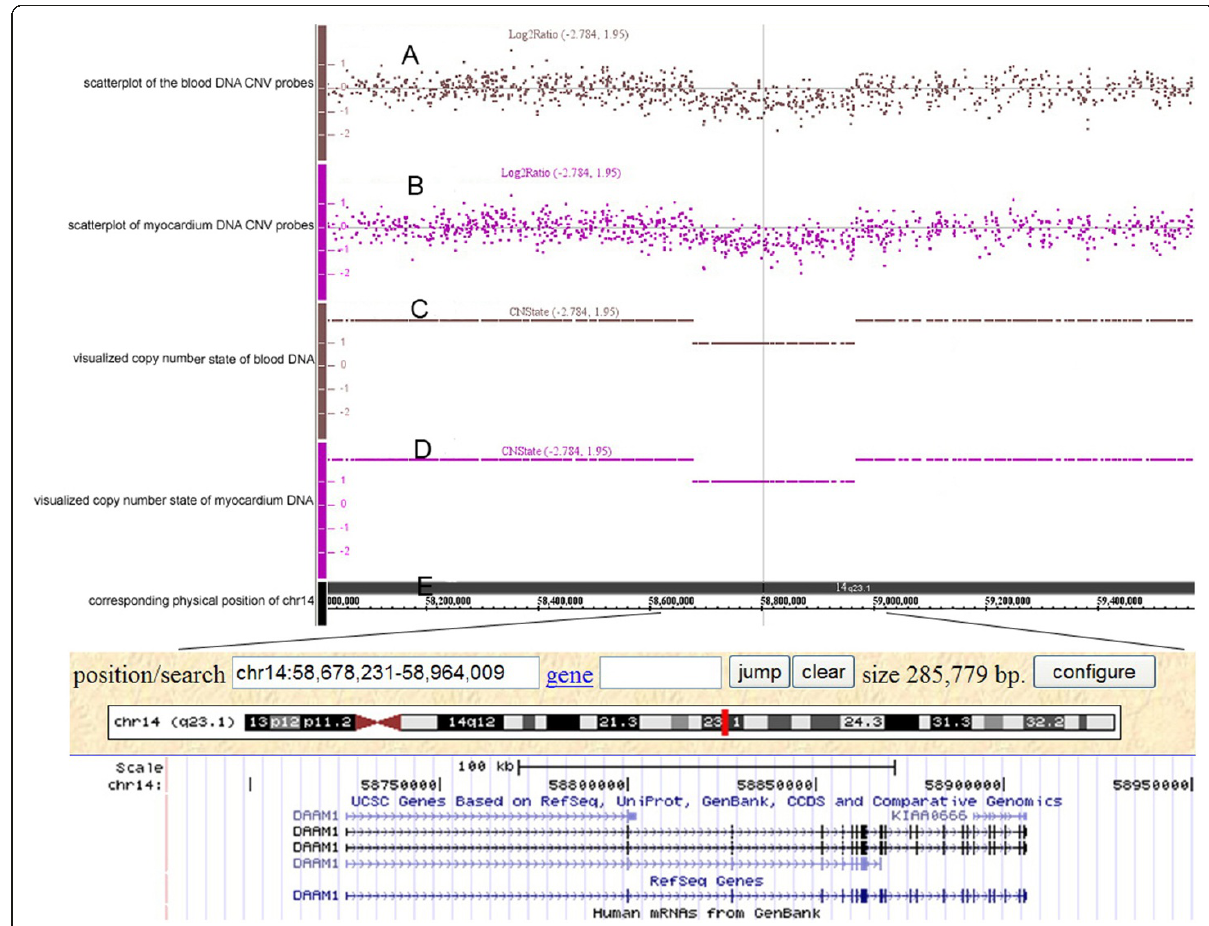
Figure 1 The copy number deletion region on 14q23.1 identified by Affymetrix SNP array 6.0 (http://www.genome.ucsc.edu/). Scatter plots with grey and purple points represented the log 2 ratio of copy number in the fetal blood DNA ( A ) and myocardium DNA ( B ) respectively. The baseline in A and B was marked as normal copy number while the spots above the baseline means amplification and below the baseline deletion. Visualized DNA copy number in the fetal blood ( C ) and myocardium ( D ) was obtained from the mean of probe signals. Physical locus of the deletion on 14q23.1 is shown in panel E. Both DAAM1 and KIAA0666 genes were harbored (as of March 2006).